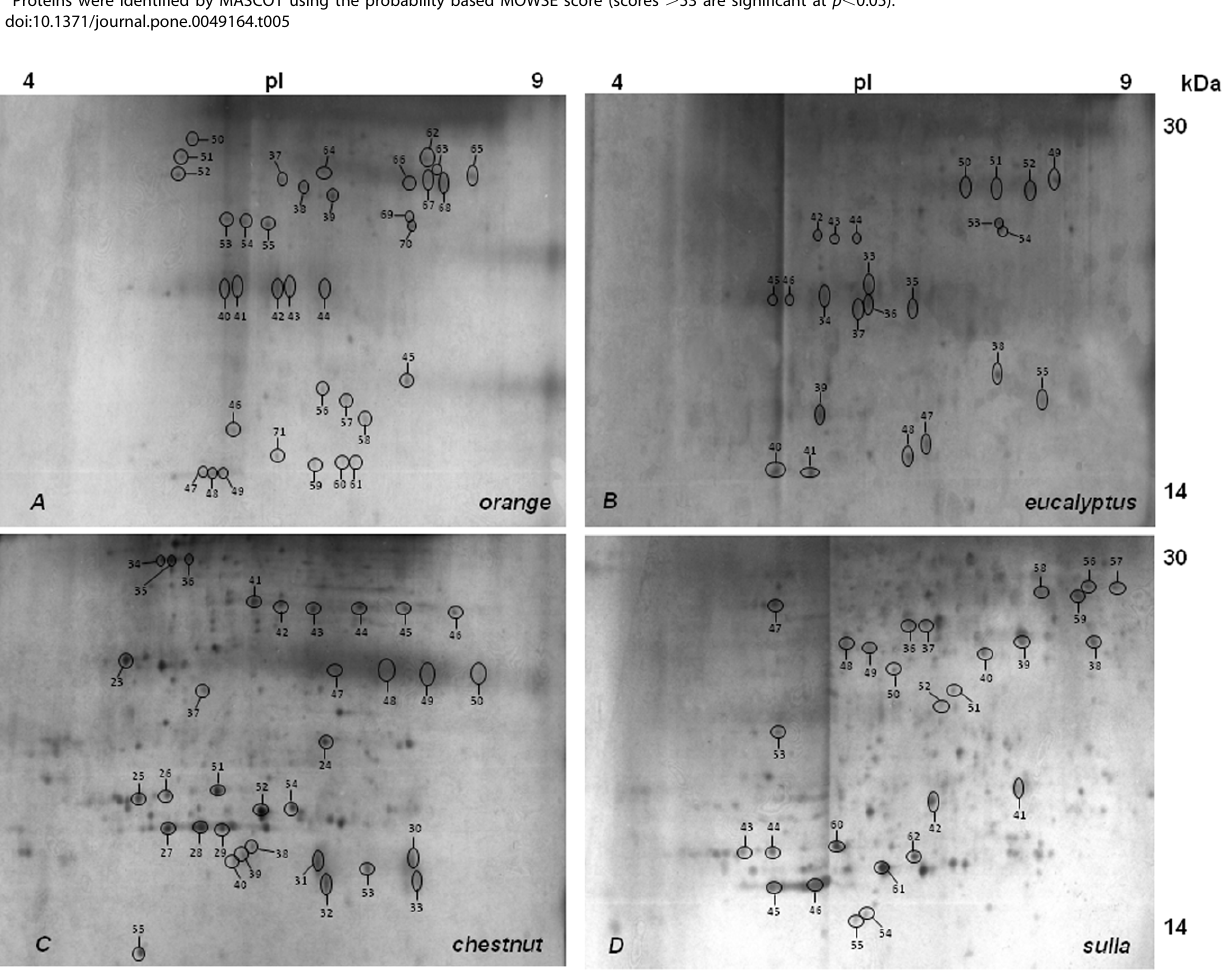
Figure 7. Bidimensional electrophoresis (2-DE) of proteins present in different unifloral honey MT1 samples. 2-DE analysis (IEF: linear pH gradient of 3–10; SDS-PAGE: 15% polyacrylamide). Silver stained gels: A ( orange ), B ( eucalyptus ), C ( chestnut ) and D ( sulla ). Only the regions of the gels with isoelectric point between pH 4–9 and apparent molecular mass between 14–30 kDa are shown. 60 m g of proteins were applied to each gel. Numbers corresponds to the protein spots identified by MALDI-ToF MS